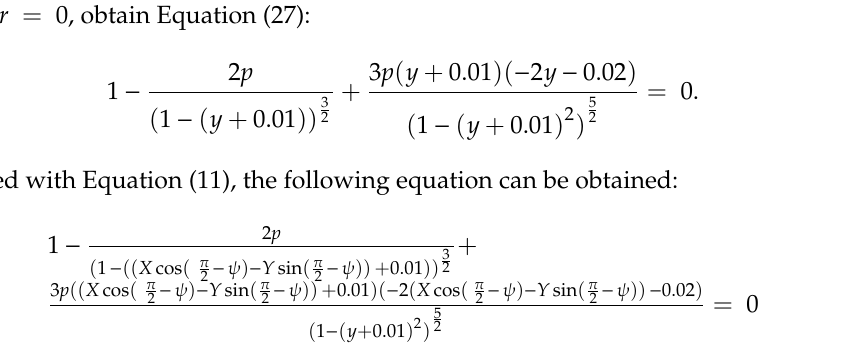
Figure 10. q ( r , p ) curves for the deformed gyroscope.